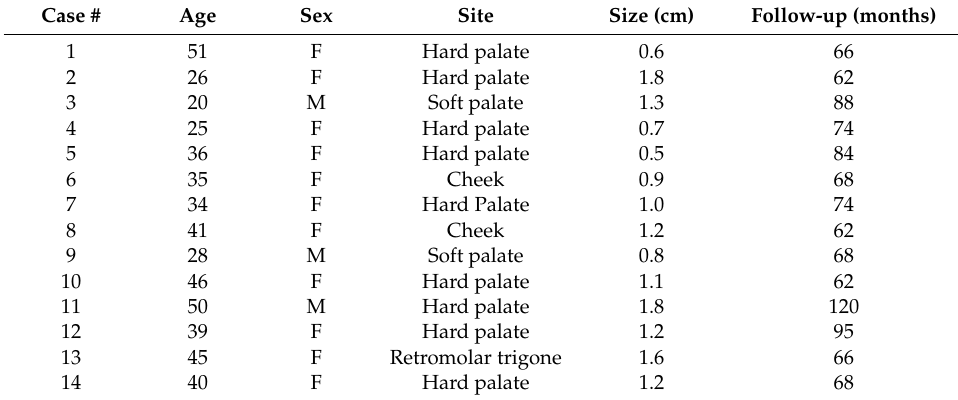
Table 1. Clinico-pathological features of the patients with intra-cystic mucoepidemoid carcinoma (all alive without evidence of disease after the specified follow-up interval).